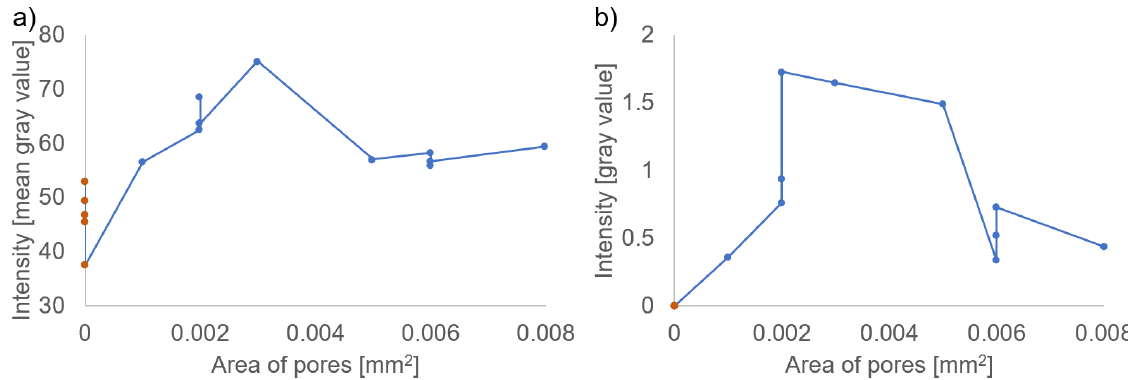
Figure 7. ( a ) Plot of intensity variation mean-grey values of hot vapor plume with pore dimension, and ( b ) the value of high intensity area from the plume for each identified pore dimension.